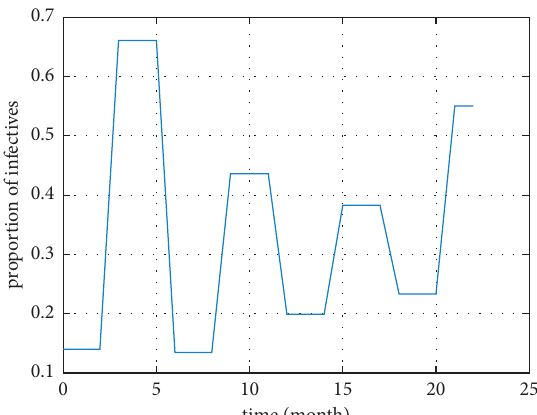
Figure 13: Te proportion of the infective from March 2020 to January